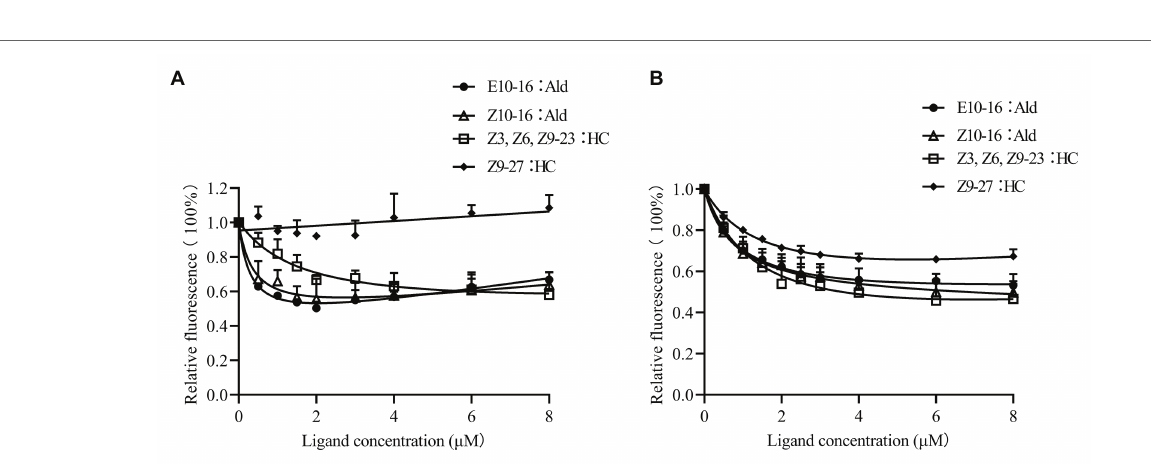
FIGURE 9 | Binding curve and relative Scatchard plot for 1-NPN/CpunOBP2 (A) and 1-NPN/CpunPBP5 (B) .